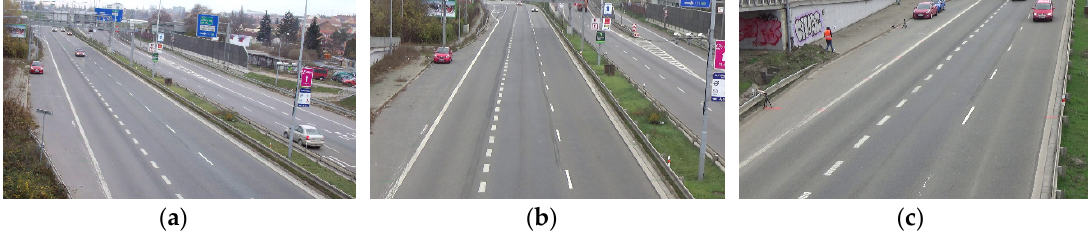
Figure 10. Dataset road scene. ( a ) Scene 1; ( b ) Scene 2; ( c ) Scene 3.